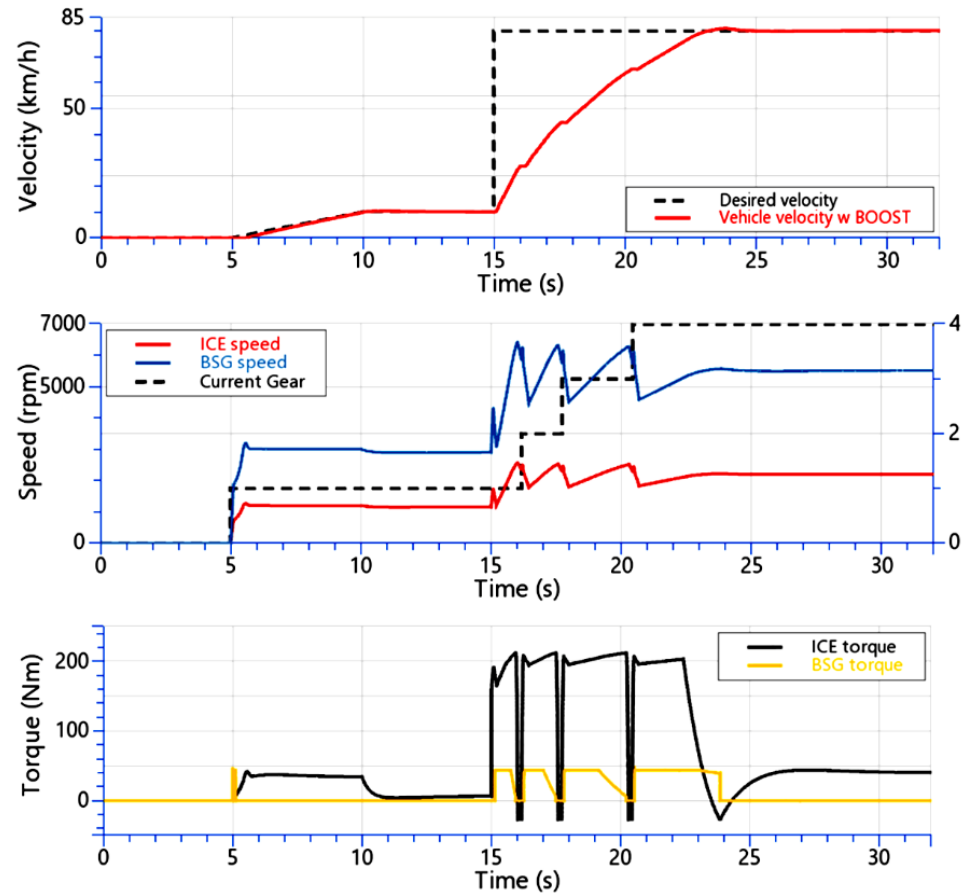
Figure 16. CRUISE TM M simulation results for ICE start-up followed by vehicle launch [10].